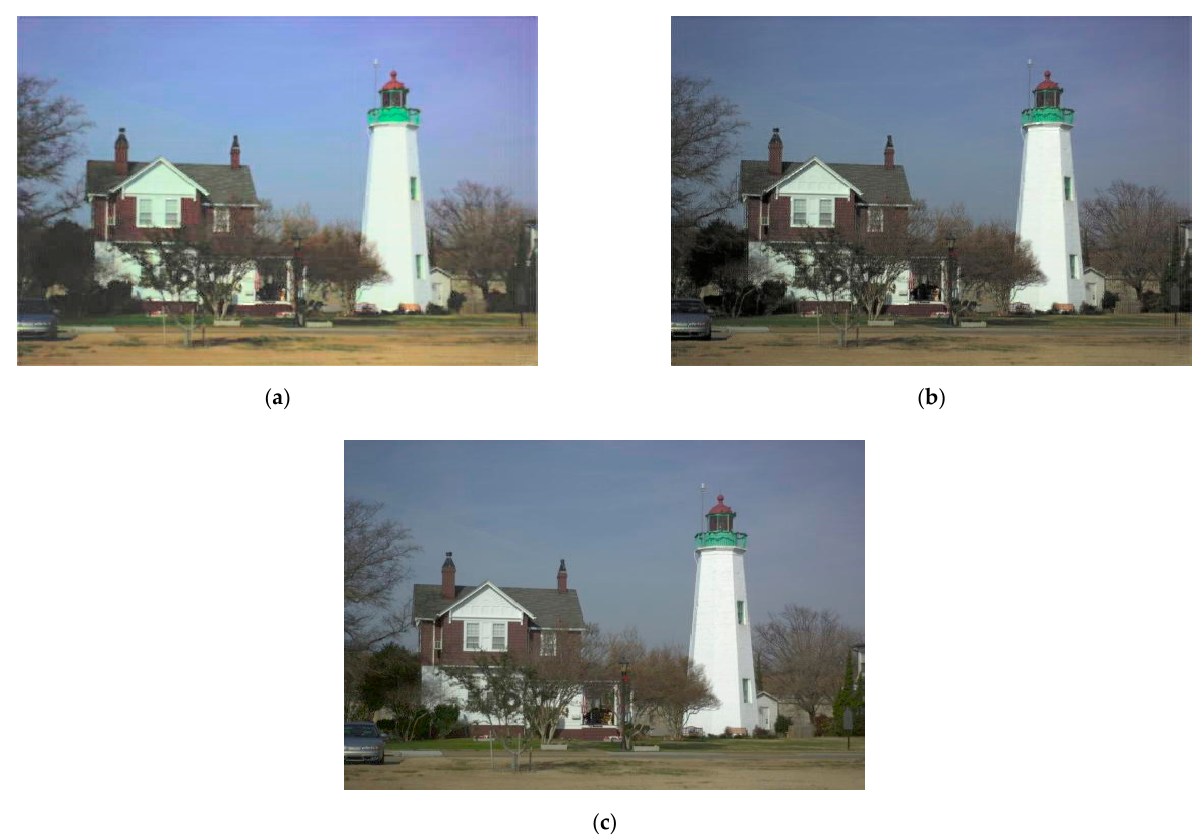
Figure 8. Comparison of general brightness augmentation and the proposed model’s gamma shift augmentation: ( a ) general brightness augmentation, ( b ) gamma shift augmentation, and ( c ) ground truth.